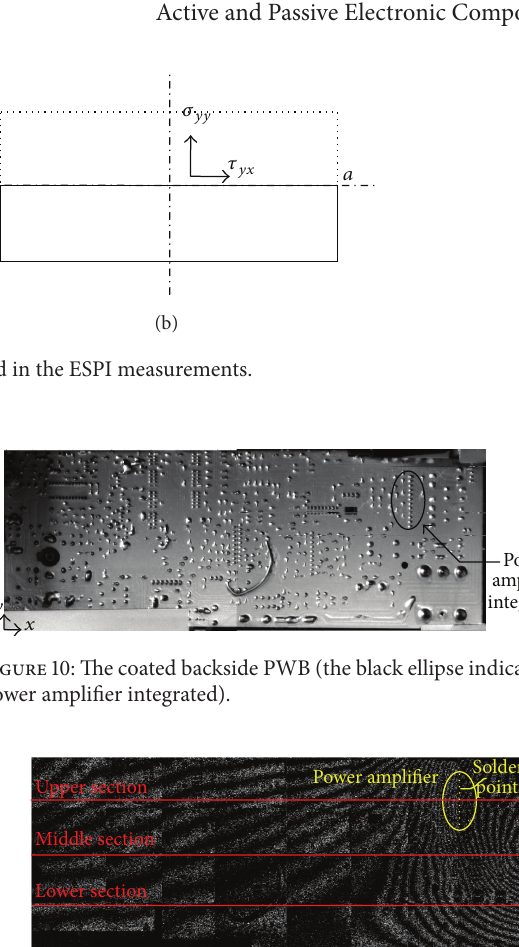
Figure 8: Strain 𝜀 𝑦𝑦 and stress 𝜎 𝑦𝑦 distribution along ( 𝑎 - 𝑎 ) section.